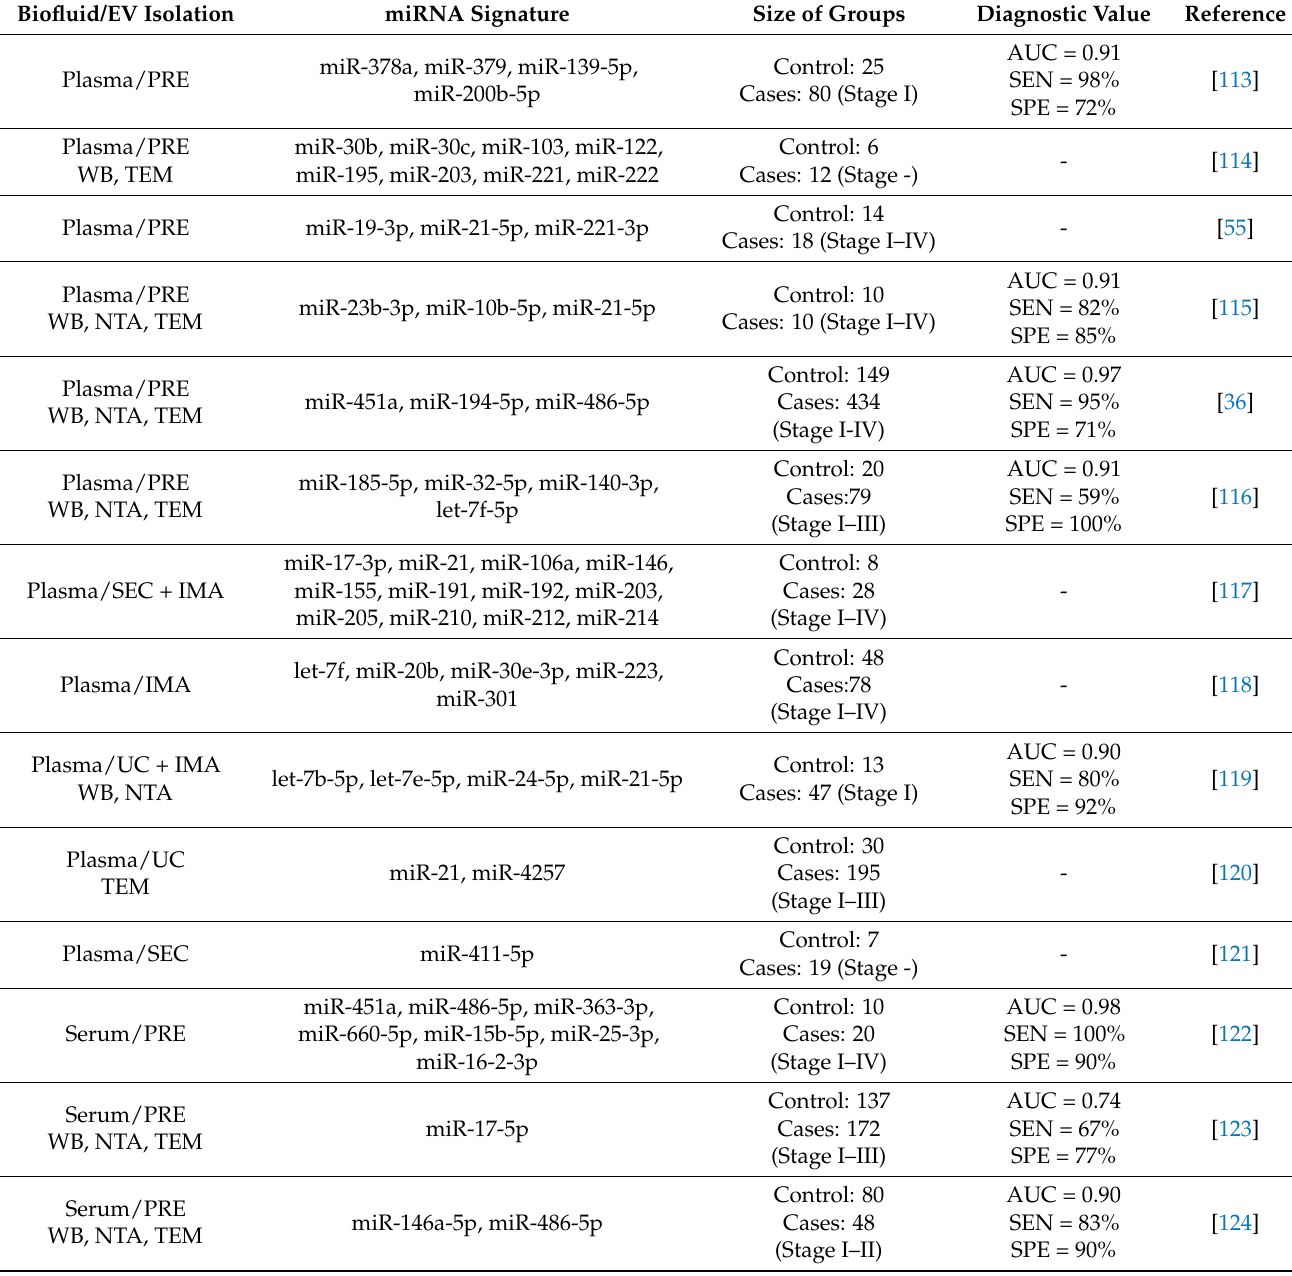
Table 3. Potential sEV miRNA biomarkers of lung